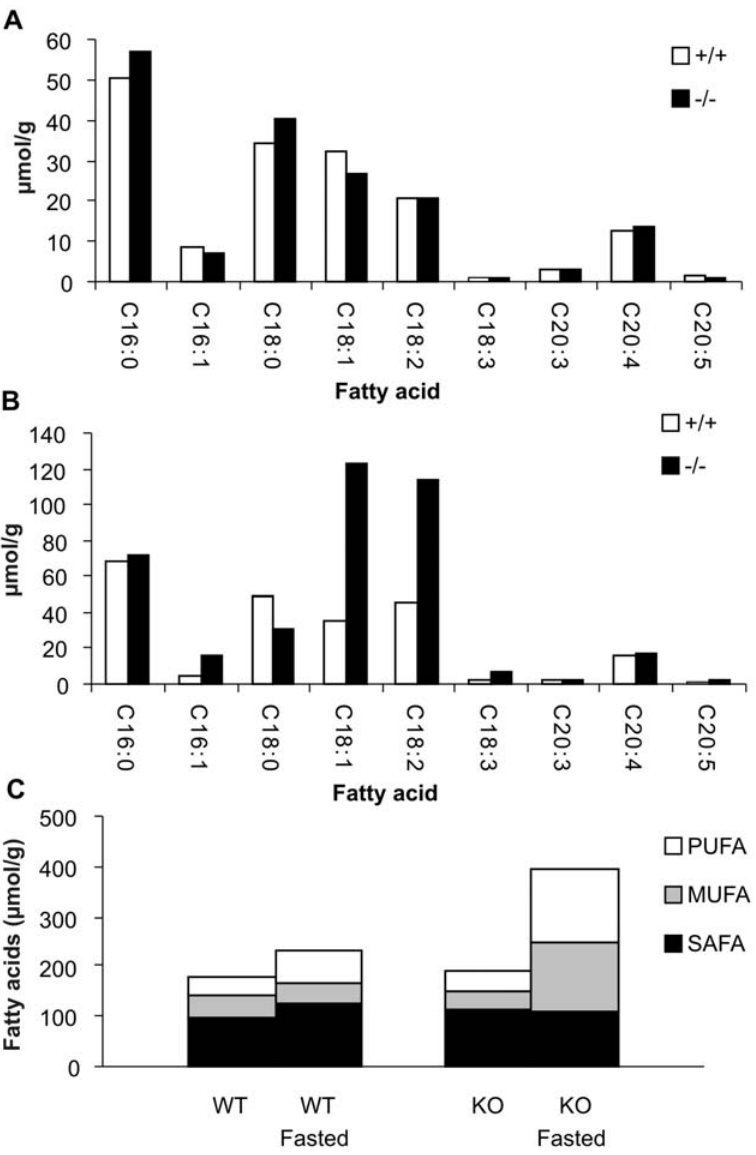
Figure 6. Fatty acid pattern of total liver lipids in fasted and non-fasted wild-type and Decr 2 / 2 mice. Total fatty acids were isolated from pooled liver homogenate samples of 5–6 mice per genotype and analyzed using positive ion mass spectrometry. (A) Fatty acid profile of total liver fatty acids under normal fed state conditions showing the concentrations of different fatty acids for wild type (open bars) and Decr 2 / 2 (solid bars) mice. (B) Fatty acid profile of liver total fatty acids after fasting for 24 h showing increased concentrations of unsaturated fatty acids in Decr 2 / 2 mice when compared with wild type mice. (C) Proportions of saturated fatty acids (SAFA), monounsaturated fatty acids (MUFA), and polyunsaturated fatty acids (PUFA) among the total liver fatty acids in wild type (WT) and Decr 2 / 2 (KO) mice in the fed state and after 24 h of fasting (fasted). initial diagnosis of long-chain fatty acid oxidation disorders is most often performed by analyzing serum or plasma acylcarnitines.